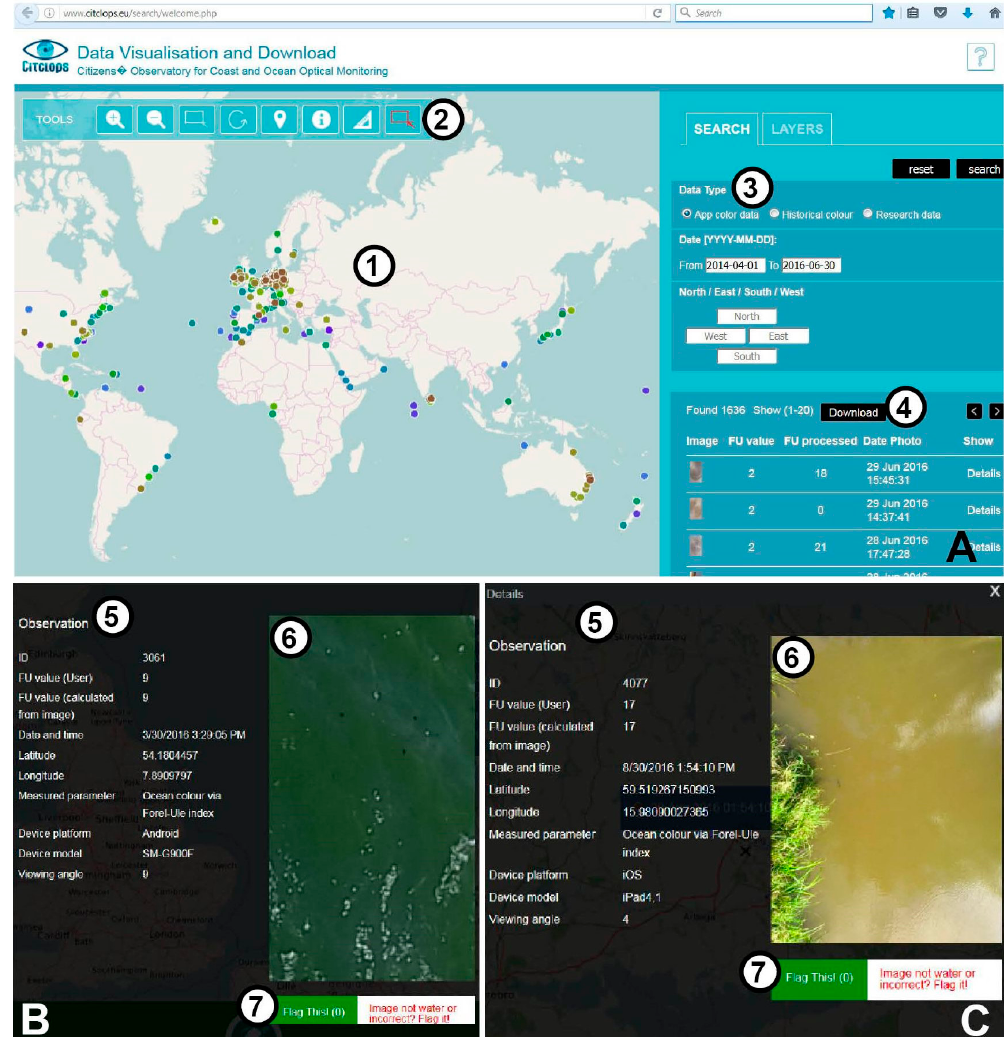
Figure 4. ( A ) Affordable tools data visualisation and download website, shown here for EyeOnWater-Colour measurements [31] with a (1) display of data points on a map, (2) spatial data selecion tools, (3) selection of data type (app, historical, research data) and time frame, (4) and a quick view of selected data with download option; ( B ) Single data points are displayed on mouse click on the EyeOnWater-colour website (screenshot) [25]. (5) Shown observation details include the measured parameter Forel-Ule water colour as determined by the user and calculated from the image, as well as basic metadata, such as sample ID, date, time, location, parameter description, viewing angle and device platform and model, as well as (6) the image of water colour and (7) a Flag this option in case the image is not of water surface; here shown for Android and ( C ) iOS device.